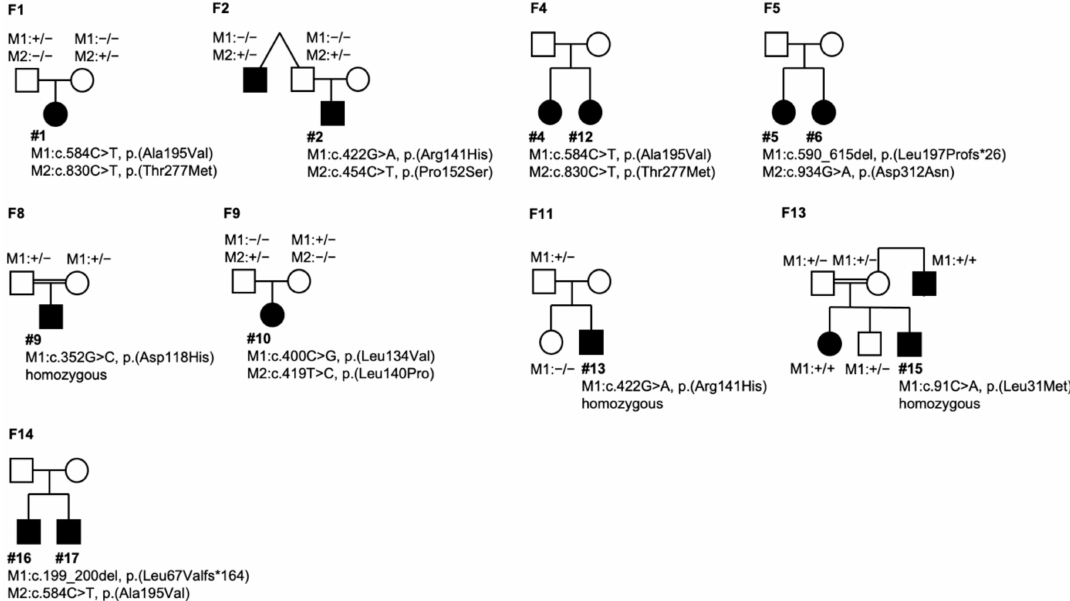
Figure 5. Schematic representation of selected family pedigrees. Ten pedigrees are shown for families where additional family members were available for DNA testing. open symbols , clinically una ff ected; solid symbols , clinically a ff ected. M, mutation, +/+ , homozygous, +/ − heterozygous, − / −